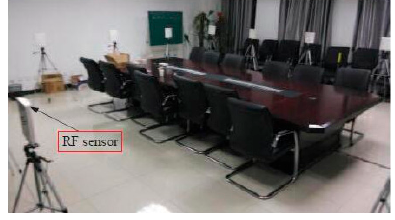
Figure 6. RTI sensor node deployment.